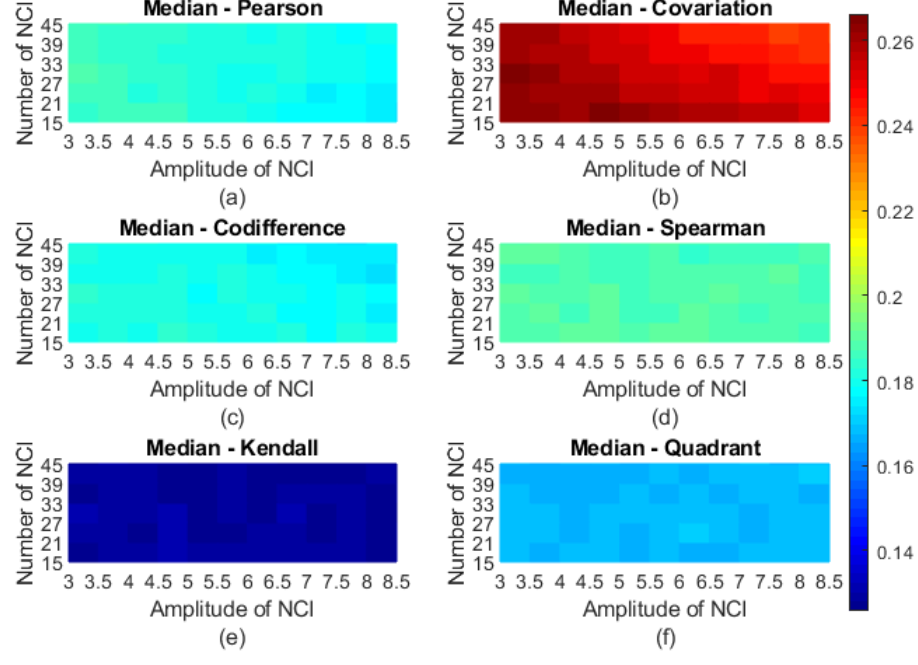
Figure 10. Medians—calculated for part C of auto-dependence maps from Monte Carlo simulation based on the following measures of dependence: ( a ) Pearson autocorrelation, ( b ) autocovariation , ( c ) autocodifference, ( d ) Spearman autocorrelations, ( e ) Kendall autocorrelation and ( f ) Quadrant